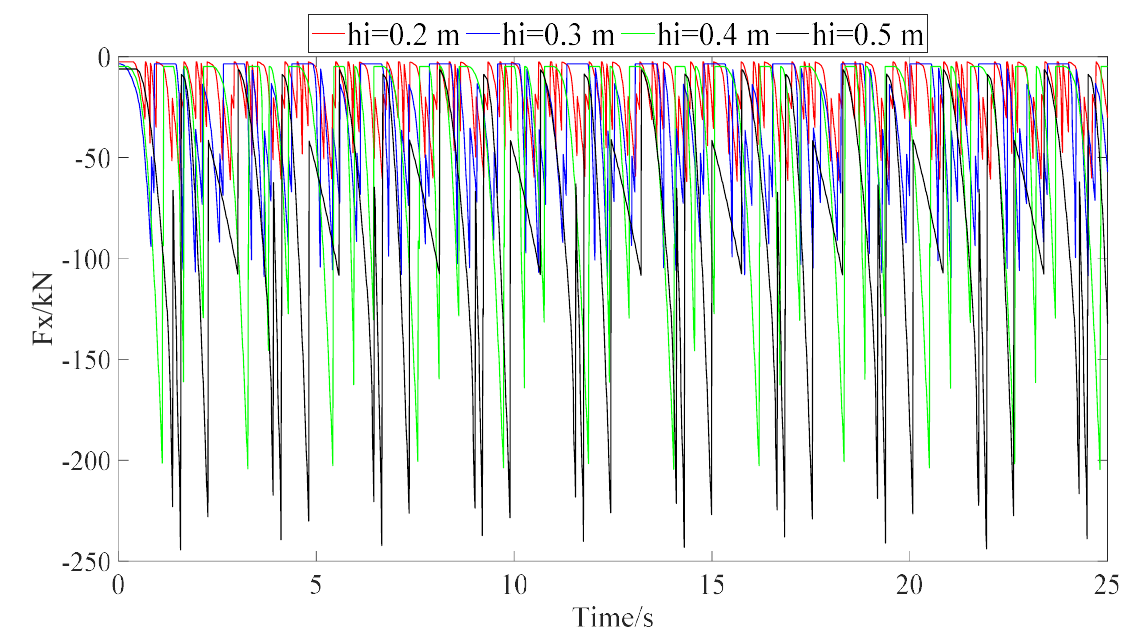
Figure 16. Time history curves of total ice force under different ice thickness (hi).